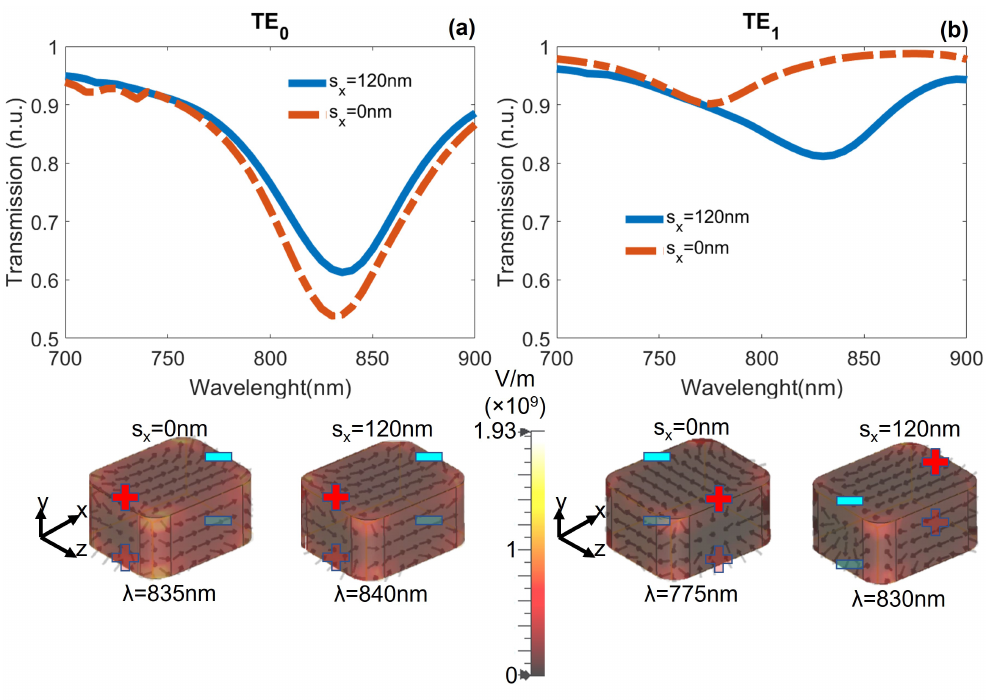
Figure 3. Transmission spectra for ( a ) TE 0 and ( b ) TE 1 modes with a short NP embedded at the center ( s x = 0 nm) and out of the center ( s x = 120 nm) of the core. The lower schematics show the electric field lines on the NP: dipoles along x for the TE 0 mode, and dipoles along z and x for the TE 1